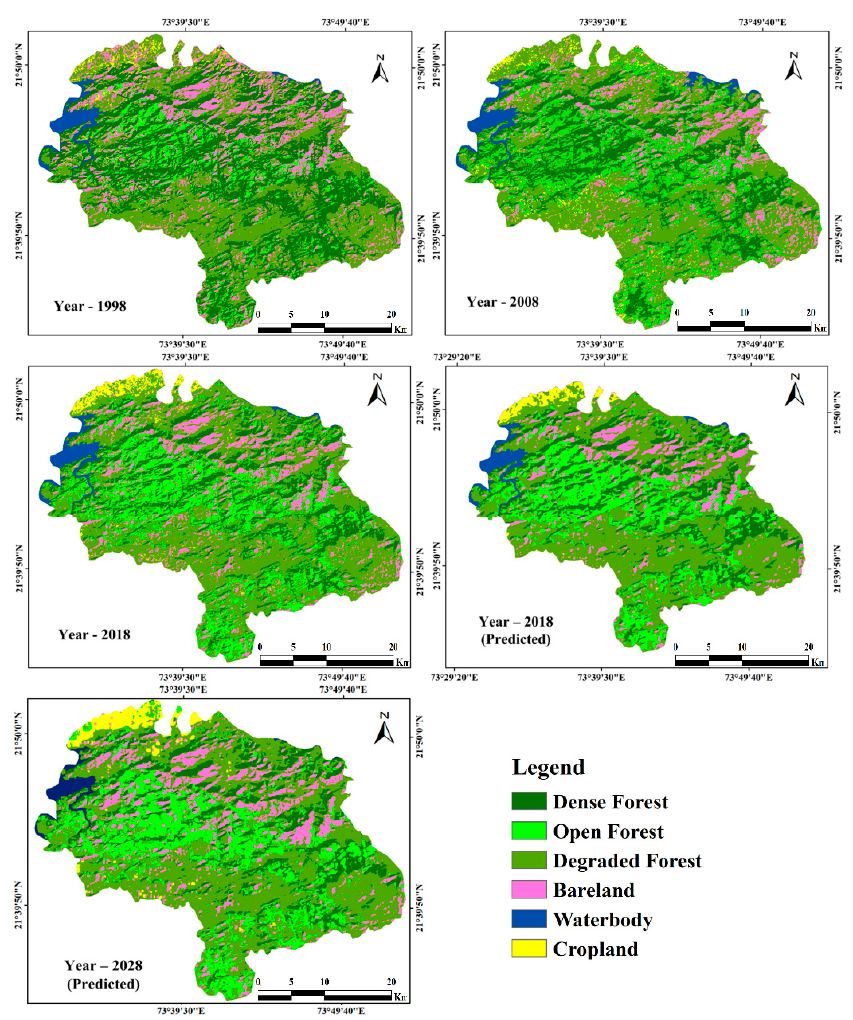
Figure 3. Forest cover maps of year 1998, 2008, 2018, 2018 (Predicted) and 2028 (Predicted).